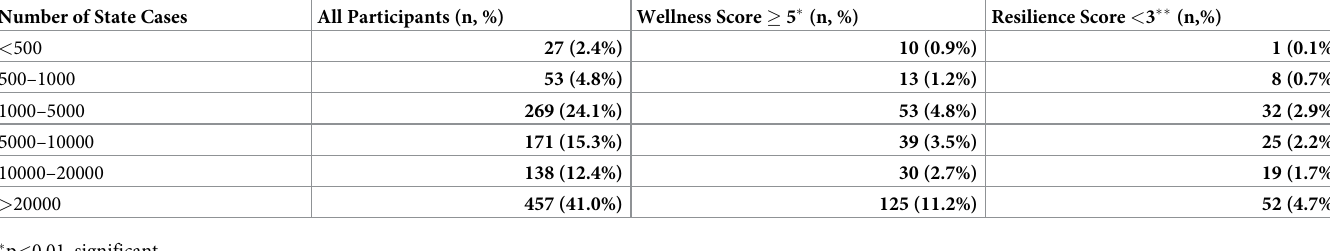
Table 3. The distribution of survey participants relative to case count per state correlated with wellness and resilience